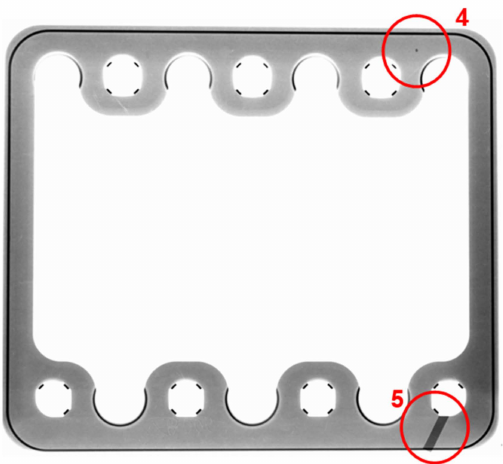
Figure 5. X-ray microradiography of the cell element. Defects (4) and (5) as defined in Figure